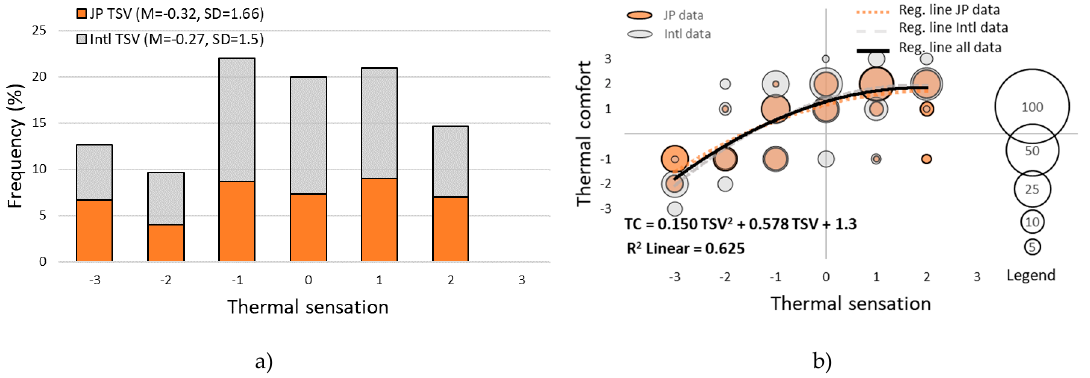
Figure 9. The frequency distributions and correlation between thermal responses; ( a ) Distribution of TSV; ( b ) correlation TC: TSV